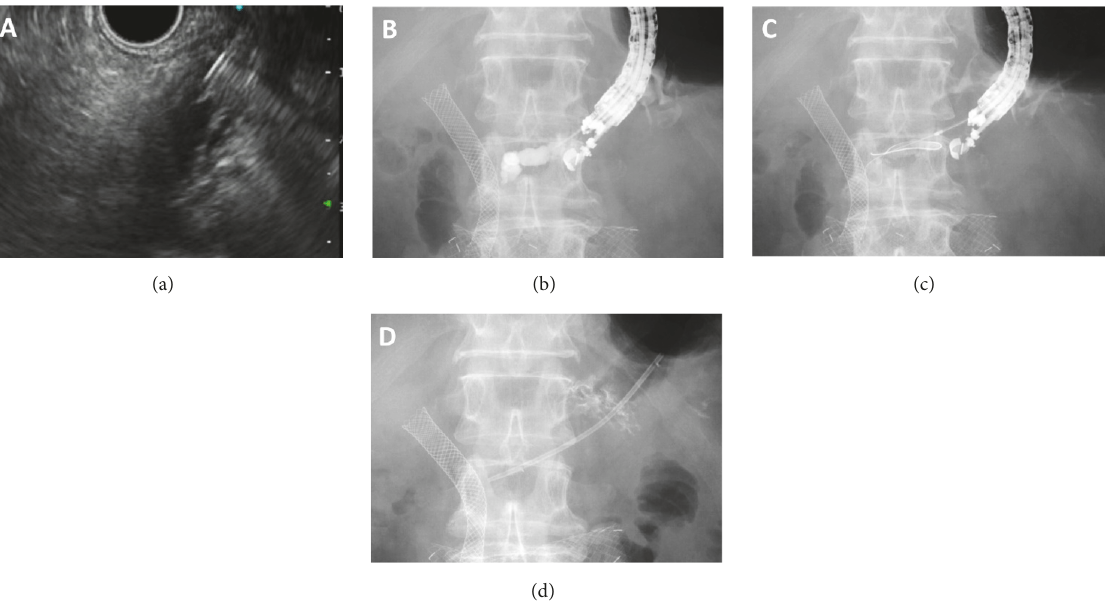
Figure 1: The EUS-PD procedure for a patient with obstructive pancreatitis due to pancreatic head cancer. (a) The pancreatic duct was punctured via the stomach with a 19-gauge needle under EUS guidance. (b) The pancreatogram was obtained by the injection of contrast agent. (c)A0.025-inch guidewire wasadvanced intothepancreatic duct,and thetractwas dilated usinga long-tapered catheter oradiathermy catheter. (d) A 7-Fr plastic stent was inserted over the